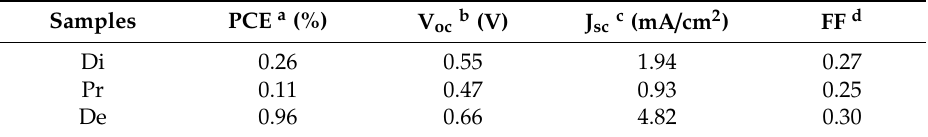
Table 1. Data extracted from reverse scanning J–V curves of perovskite solar cells (PSCs) based on Process 1. The letter Di, Pr, De represent films prepared with Direct method, Proportional method, and Delayed method, respectively. The device active area is 0.25 cm 2 (0.5 cm × 0.5 cm). The meaning of Process 1, Direct method, Proportional method and Delayed method is described in the second paragraph of experimental Section 2.2.2. Samples PCE a (%) V oc b